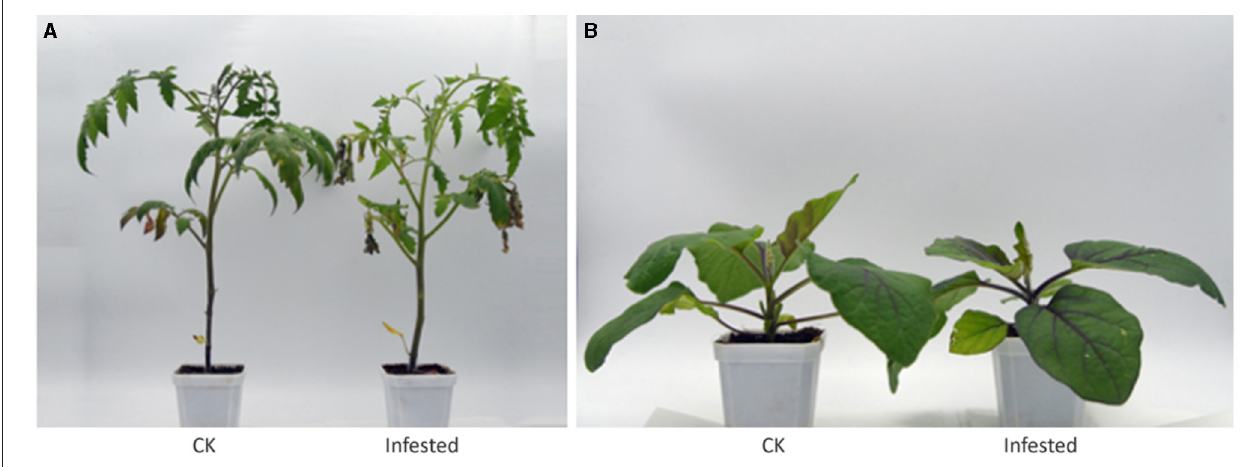
FIGURE 1 | Healthy and infested plants of tomato (A) and eggplant (B) . The infested plants were obtained in a growth chamber 48h post- T. absoluta infestation. CK, control